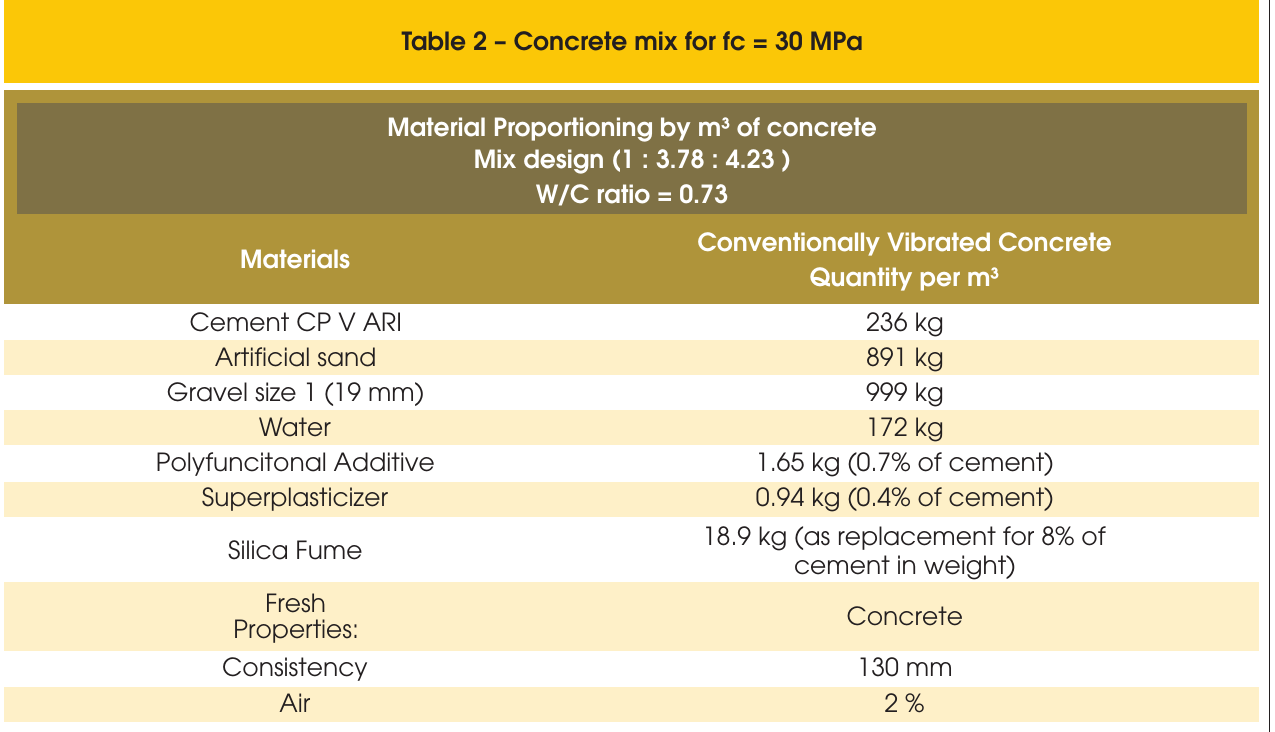
Table 2 – Concrete mix for fc = 30 MPa Material Proportioning by m³ of concrete Mix design (1 : 3.78 : 4.23